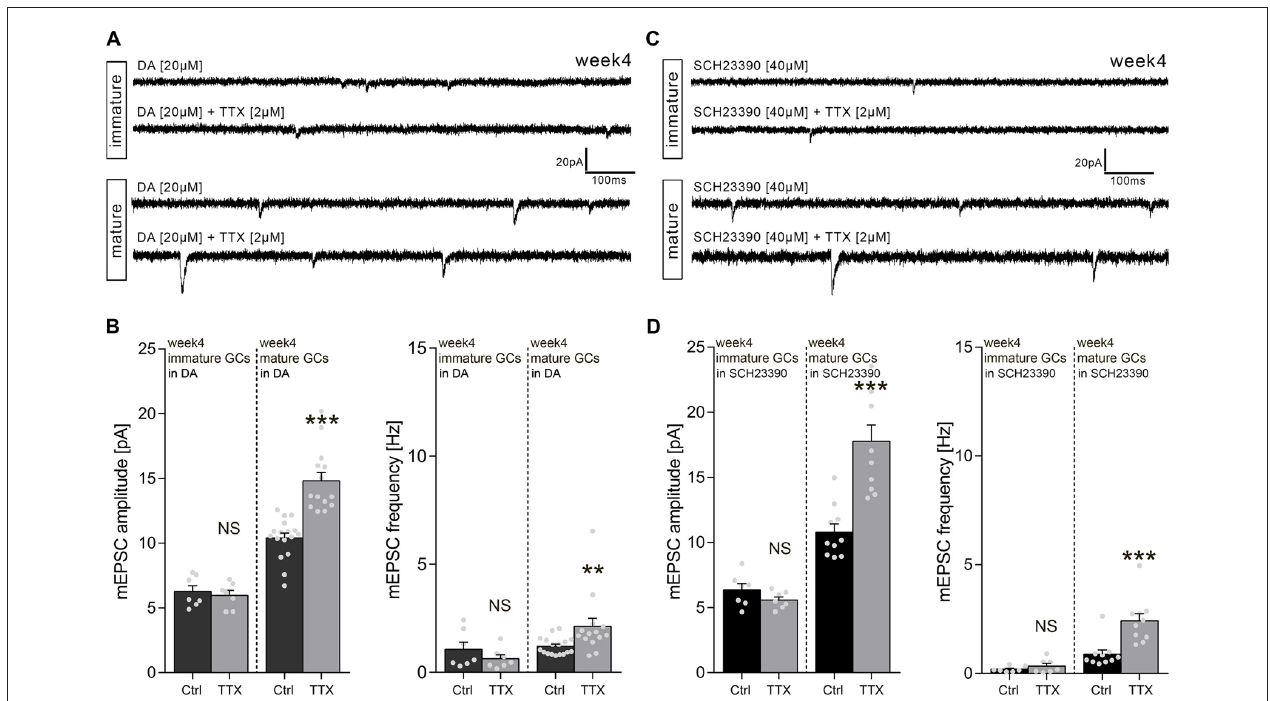
FIGURE 4 | Dopamine (DA) has no effect on homeostatic excitatory synaptic plasticity of GCs in 4-week-old slice cultures. (A) Sample traces of AMPA receptor-mediated mEPSCs recorded from immature and mature GCs of 4-week-old entorhino-hippocampal slice cultures in presence of DA-only or DA + TTX. (B) Group data of mEPSC recordings (amplitudes and frequencies) from immature and mature GCs of 4-week-old slice cultures cultures (immature: n control = 7 cells, n TTX = 7 cells; mature: n control = 17 cells, n TTX = 14 cells; Mann-Whitney test; U-values ≤ 49.5). (C) Sample traces of AMPA receptor-mediated mEPSC recorded from immature and mature GCs of 4-week-old entorhino-hippocampal slice cultures in presence of SCH23390 (D 1 / 5 receptor antagonist) or SCH23390 + TTX. (D) Group data of mEPSC recordings (amplitudes and frequencies) from immature and mature GCs of 4-week-old slice cultures cultures (immature: n control = 7 cells, n TTX = 7 cells; mature: n control = 10 cells, n TTX = 10 cells; Mann-Whitney test; U-values ≤ 6). Individual data points are indicated by gray dots. Values represent mean ± SEM ( ∗∗ p < 0.01; ∗∗∗ p < 0.001; NS, non-significant